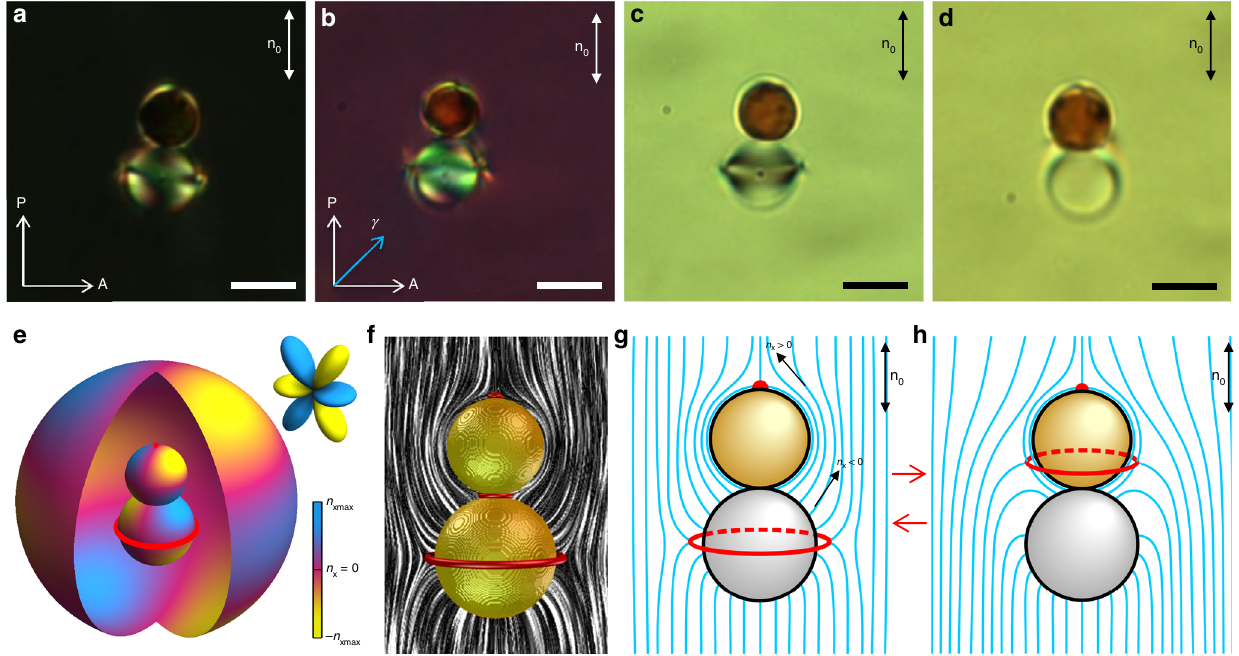
Fig. 4 Elastic multipoles induced by a pair of dissimilar particles. a – d Textures of a sample with particles in a nematic cell obtained by optical polarizing, ( b ) with and ( a ) without a retardation plate, and ( c , d ) bright fi eld microscopy. Top particle has planar and bottom particle has homeotropic anchoring. e – g Schematic diagram (blue lines) of n ( r ) ( g ) also calculated in ( f ) and ( e ) corresponding color-coded diagram of the n x directly at the surface of the particle shown in ( a – c ) and at the surface of the interpolation sphere. Inset shows a corresponding atomic orbital. h Schematic diagram of n ( r ) around a pair of particles shown in ( d ). Scale bar: 5 μ